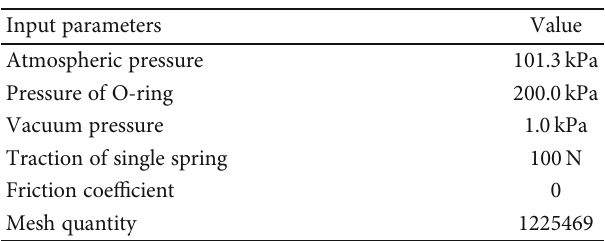
Figure 1: The speci fi c structure of quick opening mechanism. Table 1: List of input